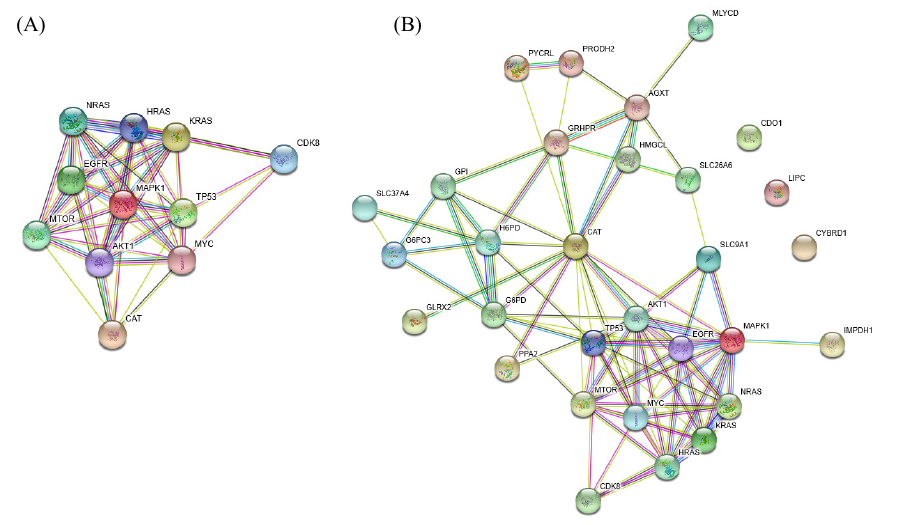
Figure 5. Protein-protein interactions (PPIs). ( A ) PPIs of the inferred oncogene CAT . CAT is strongly connected with the TP53 , mTOR , AKT1 , MAPK1 , EGFR , MYC , CDK8 , and RAS family. ( B ) CAT acts as a hub with most dysregulated genes linked to